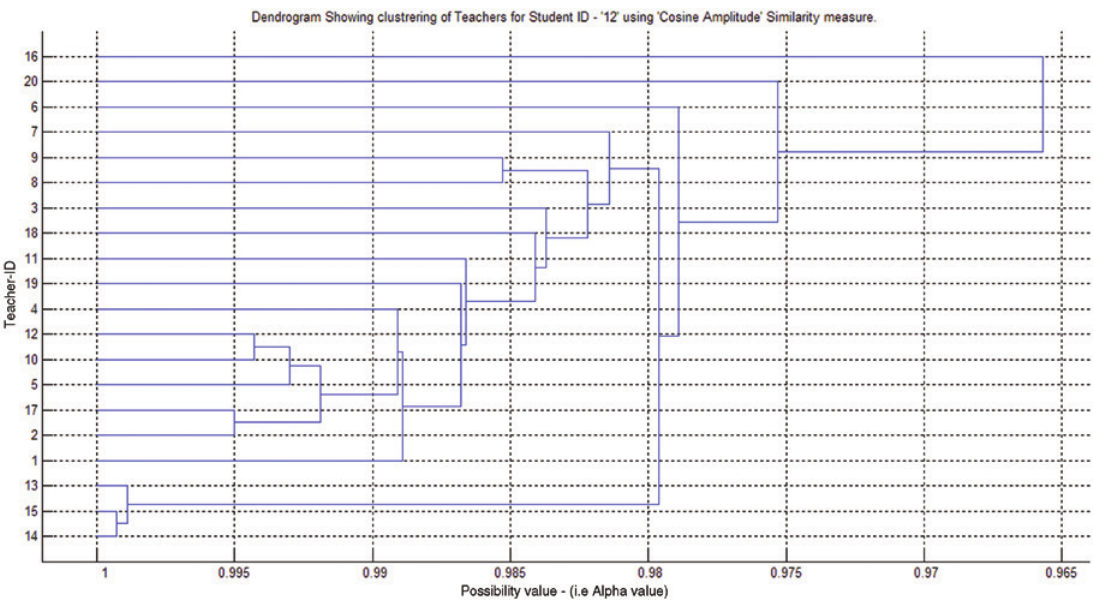
′ [ ] S for Partitioning of Teachers on Different Intervals of α -Cut Using × 12 20 20